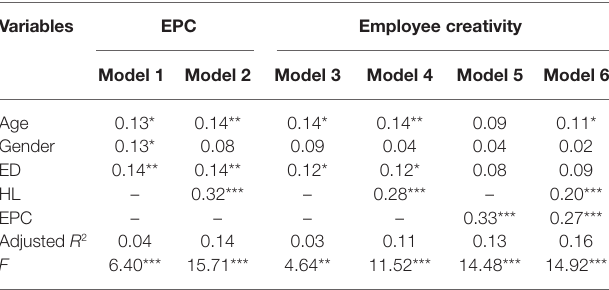
TABLE 2 | The mediation role of